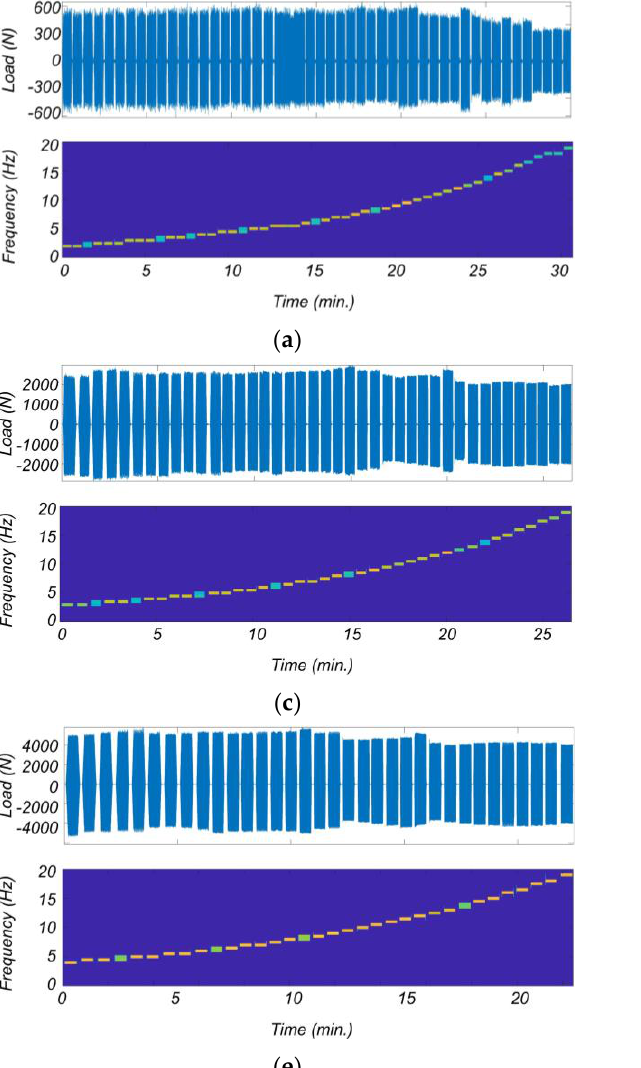
Figure 6. The field experiment setup corresponding to layout 2 (See Figure 4).